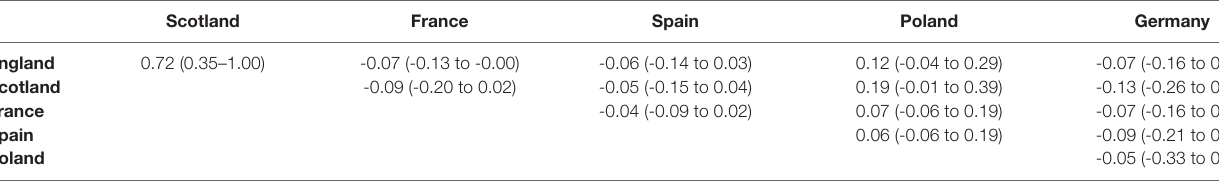
TABLE 7 | Agreement in recommendations between countries for oncologic drugs.